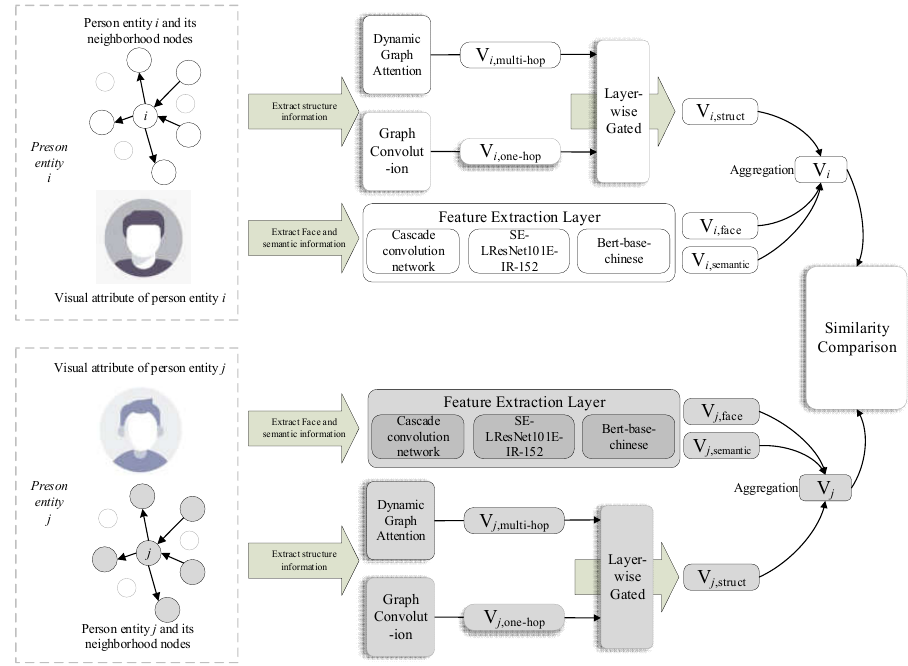
Figure 2. The model architecture of PEAMA.